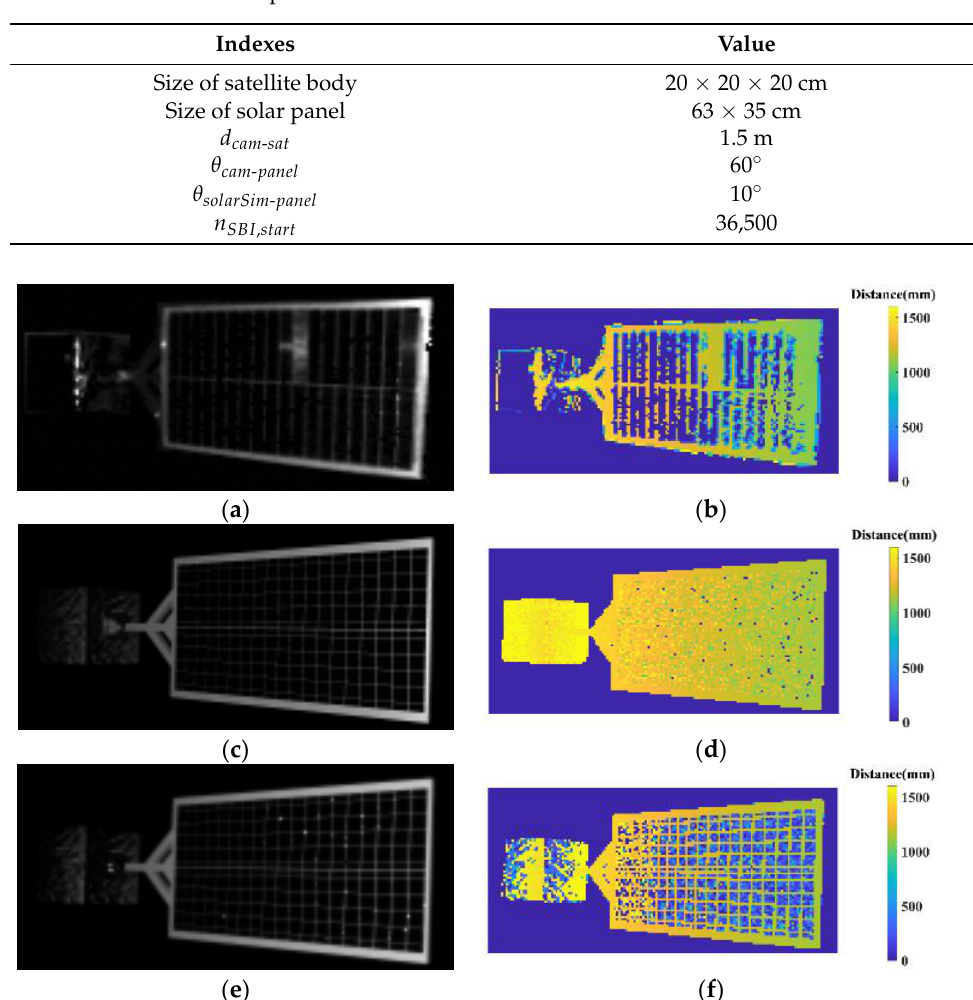
Figure 14. The measured images of the ground experiment scene (the background area is eliminated) and the corresponding simulated images. ( a ) Measured grey image; ( b ) measured depth image; ( c ) grey image simulated by the method of Ref. [22]; ( d ) depth image simulated by the method of Ref. [22]; ( e ) simulated grey image of ours; ( f ) simulated depth image of ours. ( c , d ) only consider the influence of the active light of the TOF camera and do not consider the ambient solar light. ( e , f ) consider the process of the SBI model suppressing solar ambient illumination. Table 4. Other simulation parameters used.